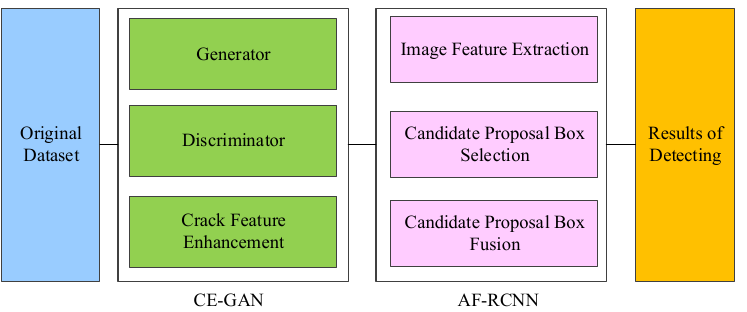
Figure 1. The framework of our model. Compared with the traditional dam crack detection algorithm, our model provides innovations in image expansion and crack detection. When the dam crack dataset is fed into the model, the expansion module effectively expands the dataset and enhances the crack feature through generator and discriminator, so as to facilitate the training of the dam crack detection network. The crack detection module extracts the feature under the action of the attention mechanism, generates candidate proposal boxes, and optimizes them. Finally, the model generates detection results.